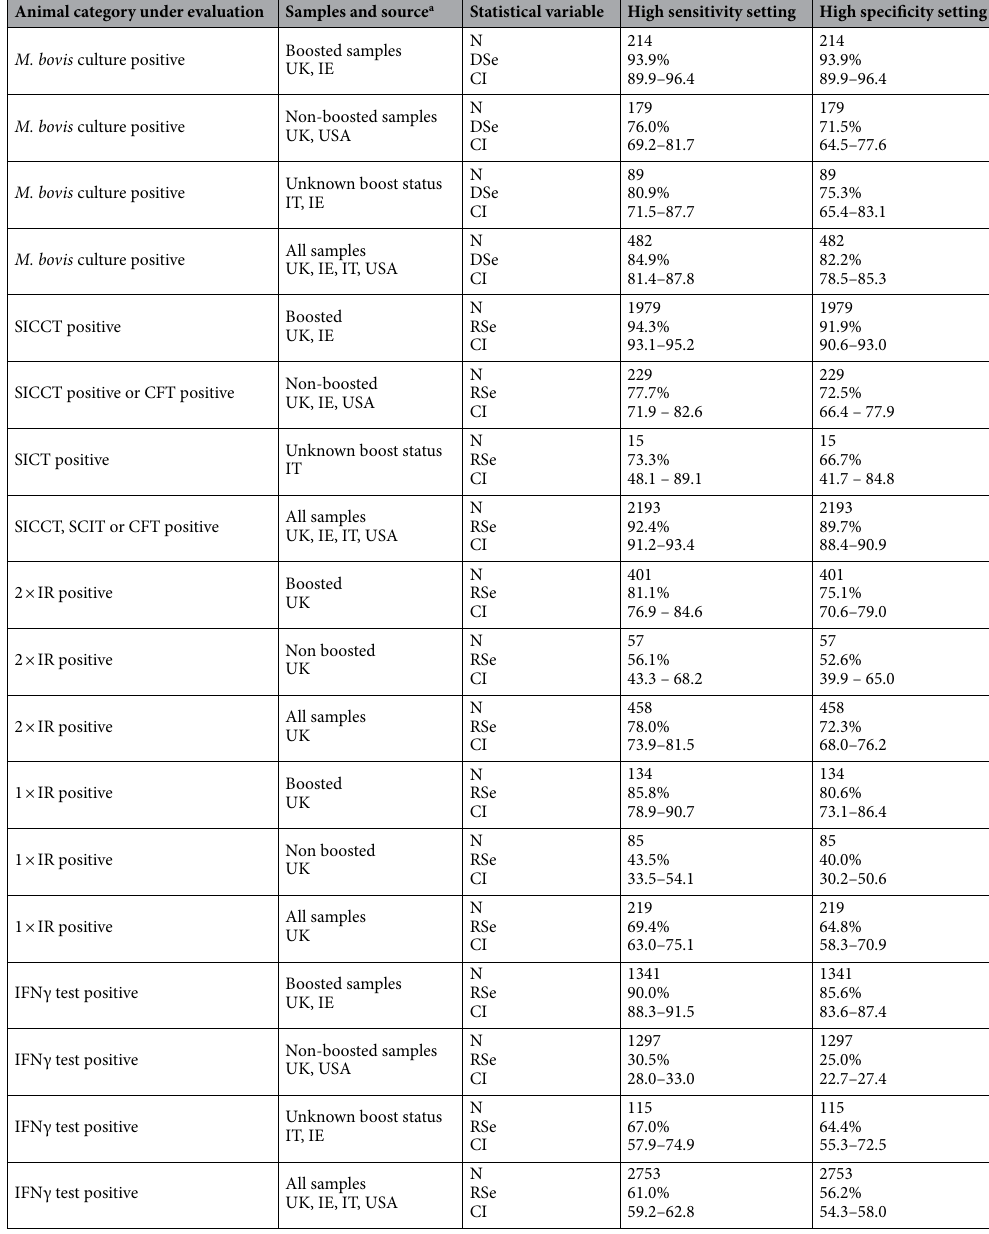
Table 4. Diagnostic sensitivity estimates of the Enferplex Bovine TB antibody test. Diagnostic sensitivity was estimated at the high sensitivity and high specificity settings using reference sera from animals positive by M. bovis culture, and relative sensitivity was similarly estimated from animals positive by SICCT, CFT, IFNγ test or SICCT inconclusive reactor (IR). a Boosted—samples taken within anamnestic window (5–30 days post tuberculin injection); non-boosted—samples taken outwith the anamnestic window; United Kingdom (UK), Ireland (IE), Italy (IT); United States of America (USA). b N = number of samples; DSp—diagnostic specificity; DSe—diagnostic sensitivity; RSe—relative sensitivity; CI—95% Confidence